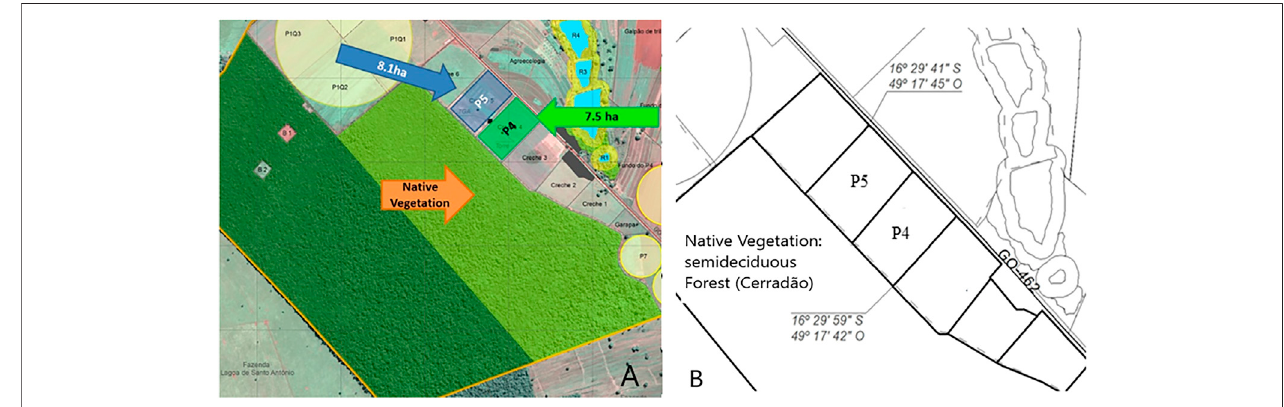
FIGURE 2 | Paddock 4 (P4) and Paddock 5 (P5) and native vegetation at Capivara Experimental Farm, Embrapa Rice and Bean in Santo Antônio de Goiás, GO,